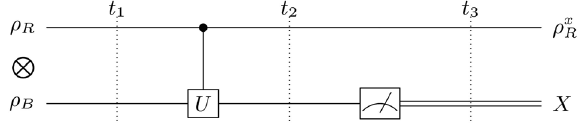
Fig. 2 Uncertainty game as a quantum circuit. Initially, at time t 1 , Alice ’ s register R and Bob ’ s system B do not share any correlations. Then Alice makes a choice of the measured observable based on the state of the (possibly quantum) coin in R by performing a conditional rotation U on B . She then performs a measurement of the observable S on B to obtain the measurement outcome X . If the register R is classical, i.e. it is diagonal on the standard basis, then these two operations of Alice effectively perform a random measurement of S or T . If there is some non-zero coherence in register R , then the effective measurement can no longer be described as a random choice of one of the two observables. After that at time t 3 Alice sends R to Bob. Bob then wants to guess Alice ’ s . Note that if R outcome X = x by trying to distinguish the states f ρ x R g is classical, then the correlations between the two systems at time t 2 can also only be classical and all the states f ρ x g will be classical as R well, implying that the optimal measurement of Bob corresponds to simply checking which one of the two observables Alice has chosen to measure. If R contains coherence, then quantum correlations between the two registers can arise at time t 2 and Bob can better distinguish the states f ρ x g by performing a measurement that takes R this coherence into account. Figure taken from 7 with modi fi cations under the licenses/CC BY 3.0 https://creativecommons.org/licenses/